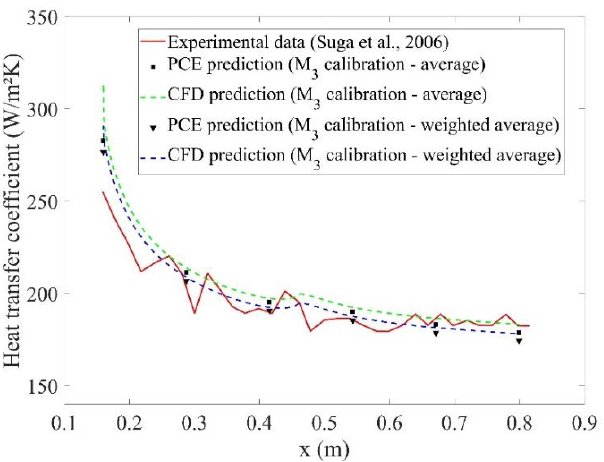
Figure 12. PCE and CFD predictions using M 3 calibrated values (genetic algorithm).